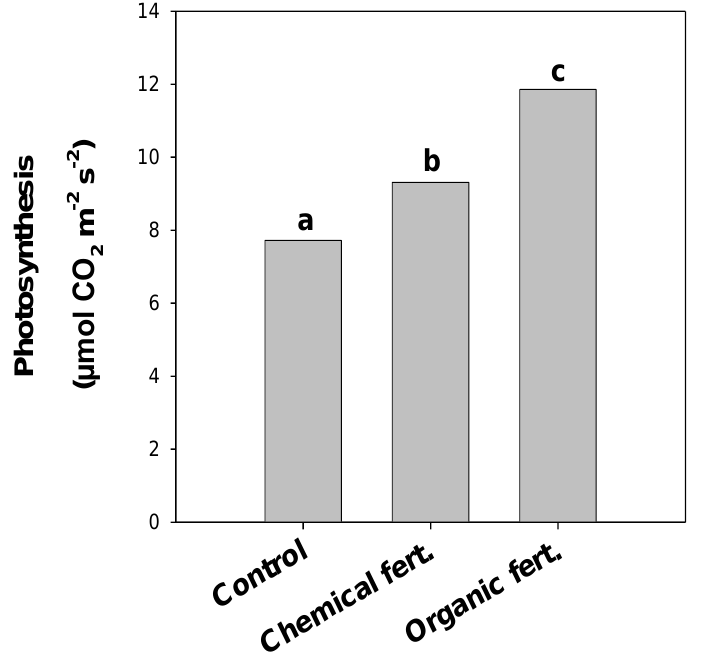
Figure 3. Photosynthetic activity of leaves of chemically or organically fertilized potted trees and of unfertilized ones (control) measured in August 2019. Means accompanied by different letters are significantly different at p < 0.05 ( n = 6).